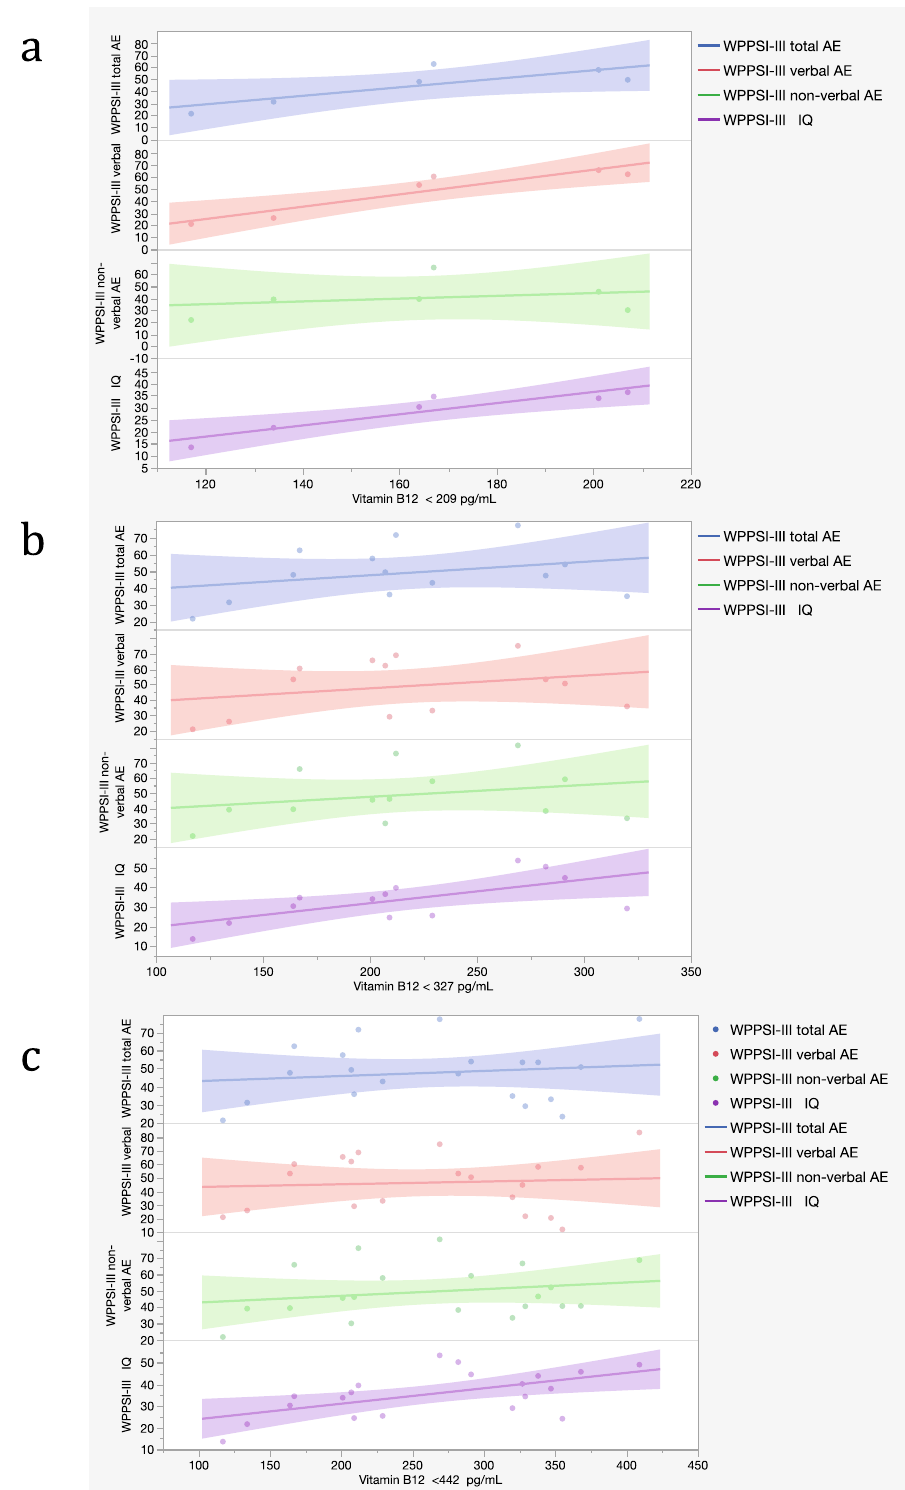
Figure 5. Scatter plot representing correlations between vitamin B12 and cognitive scores in the WPPSI-III group. ( a ) Correlations between vitamin B12 < 209 pg/mL (L group of 25th percentile threshold; 6 subjects) and WPPSI-III subtests scores. ( b ) Correlations between vitamin B12 < 327 pg/mL (L group of 50th percentile threshold; 13 subjects) and WPPSI-III subtests scores. ( c ) Correlations between vitamin B12 < 442 pg/mL (L group of 75th percentile threshold; 20 subjects) and WPPSI-III subtests scores (see Supplementary Table S3). Each dot represents a sample subject. Each line represents a correlation